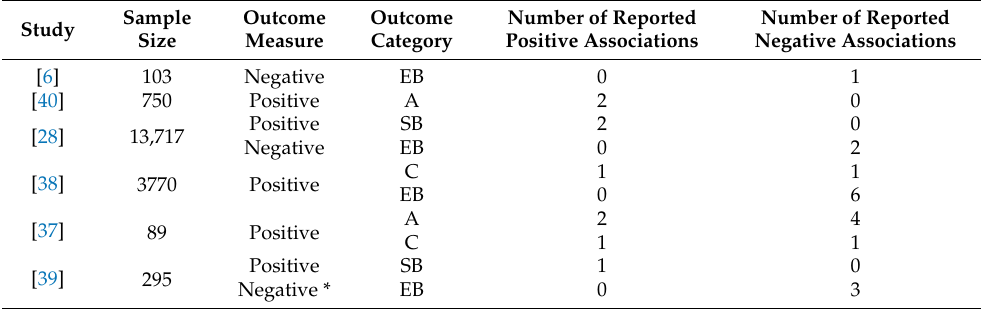
Table 5. Locomotor play—outcome measure descriptions and results summary.